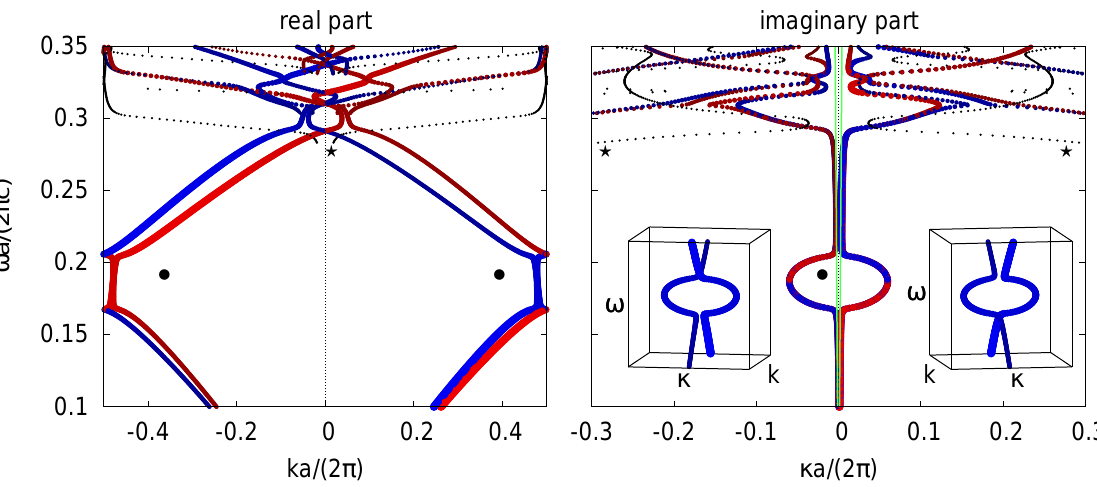
Figure 8. Complex band structure along the r 100 s direction of the truncated octahedron photonic crystal with intrinsic material chirality. The parallel wave vector is set to zero (corresponding to normal incidence); the Galerkin space contains N “ 2000 plane